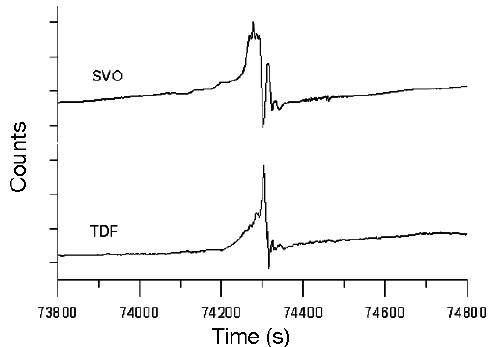
Fig. 12. The signal associated with the vulcanian ex- plosion that occurred on March 15, 2007, at about 20:37 UTC, recorded by the two strainmeters: SVO ( top ) and TDF ( bottom ). The signal reveals a pressure increase starting about 10 min before the